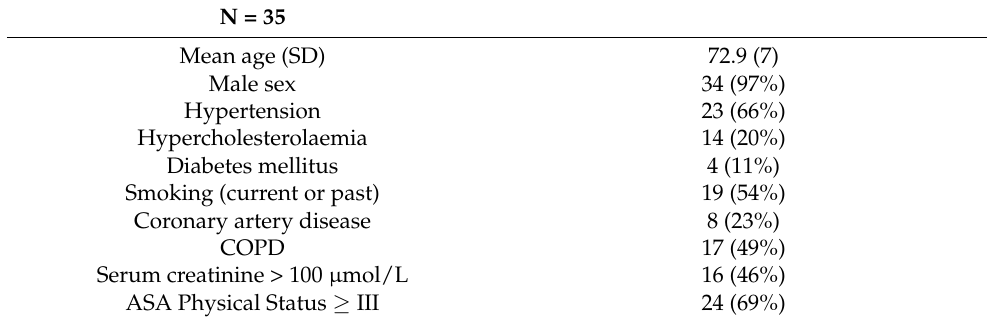
Table 1. Baseline and comorbidity characteristics. Data expressed in absolute numbers (percentage), except where indicated: mean (Standard Deviation). COPD: chronic obstructive pulmonary disease. N = 35 Mean age